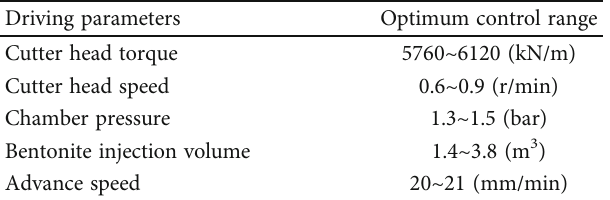
Table 3: Optimum control range of the driving parameters. Driving